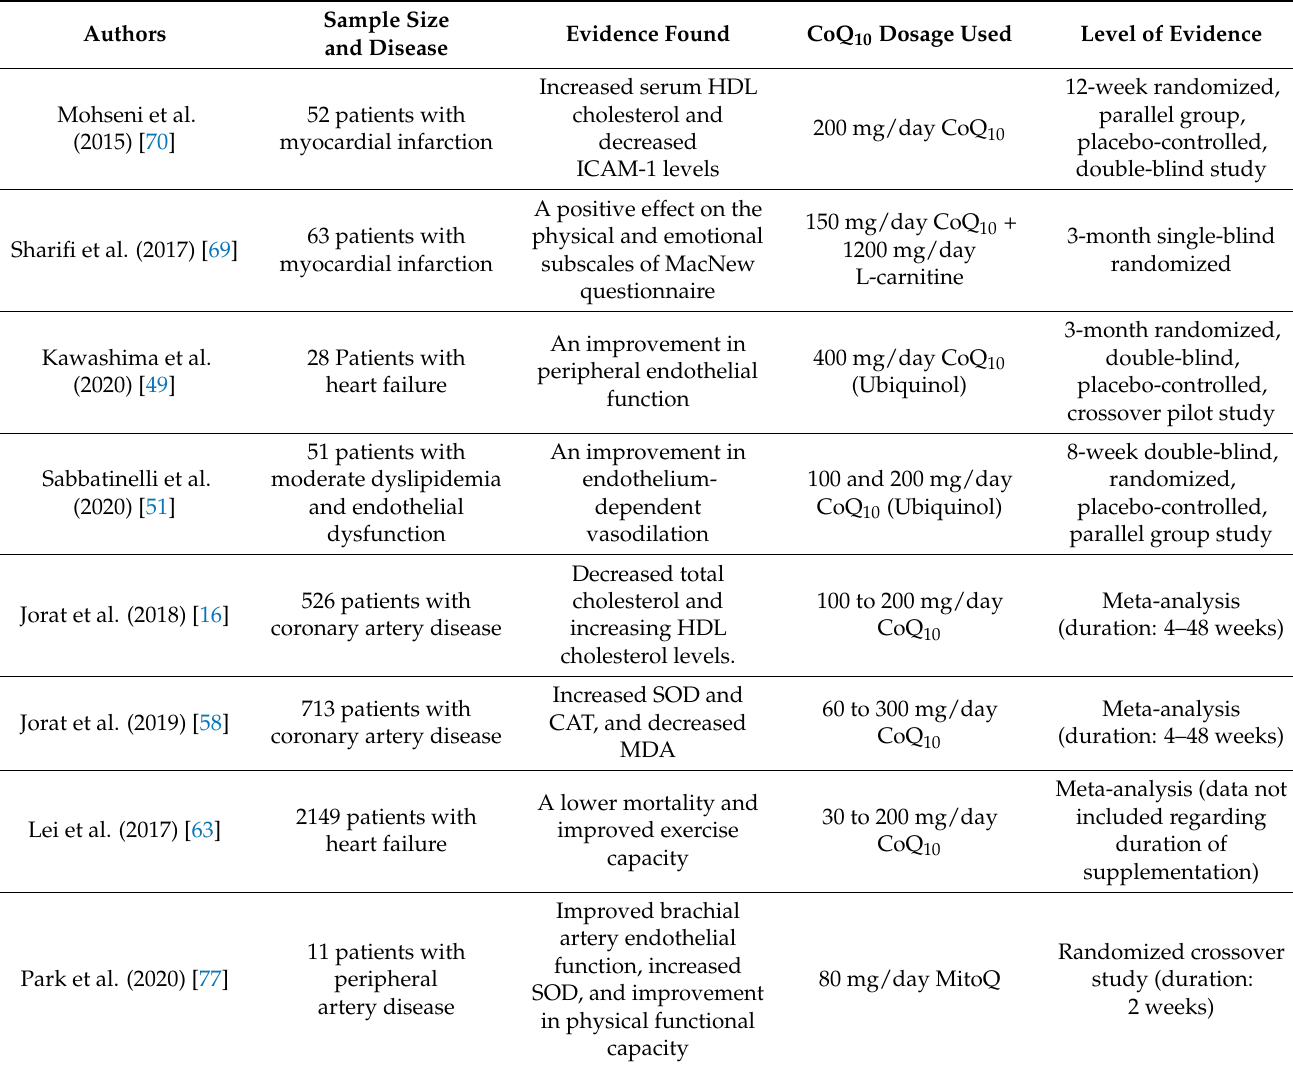
Table 1. Coenzyme Q 10 supplementation in recent studies in humans and its relation to cardiovascular disease.